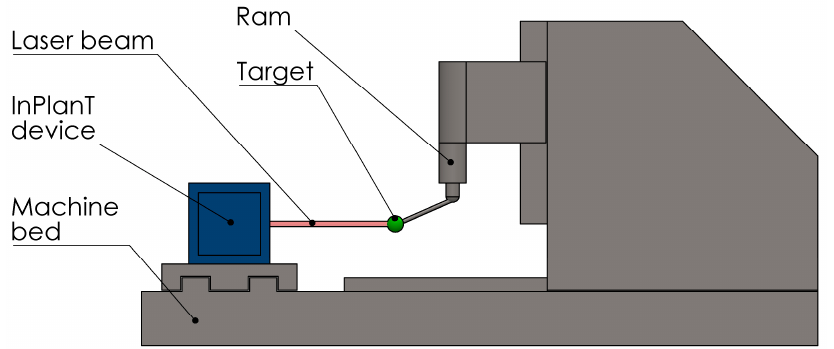
Figure 1. Schematic of a straightness measurement of a machine tool.